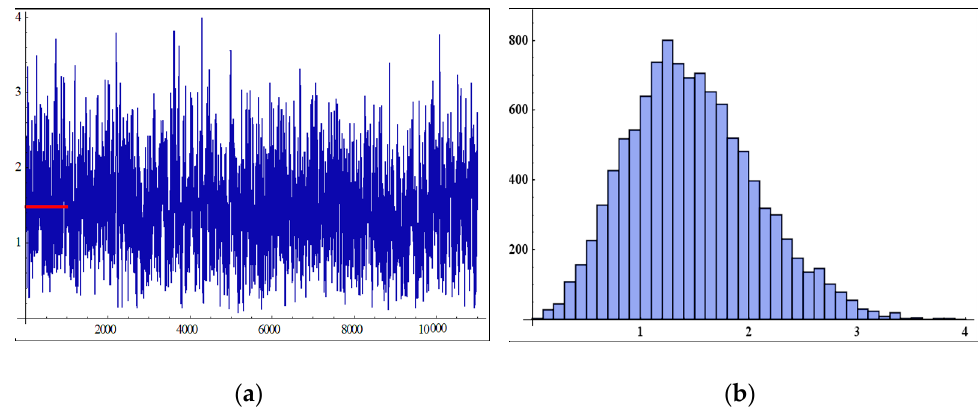
Figure 3 ． ( a ) Simulation number of obtained by MCMC method. ( b ) Histogram of obtained by MCMC method.